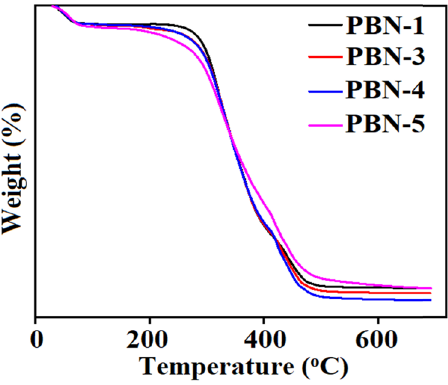
Figure 4: TGA graphs of MMT - reinforced crosslinked PVA nano fi bers only and with di ff erent concentrations of the root extract.